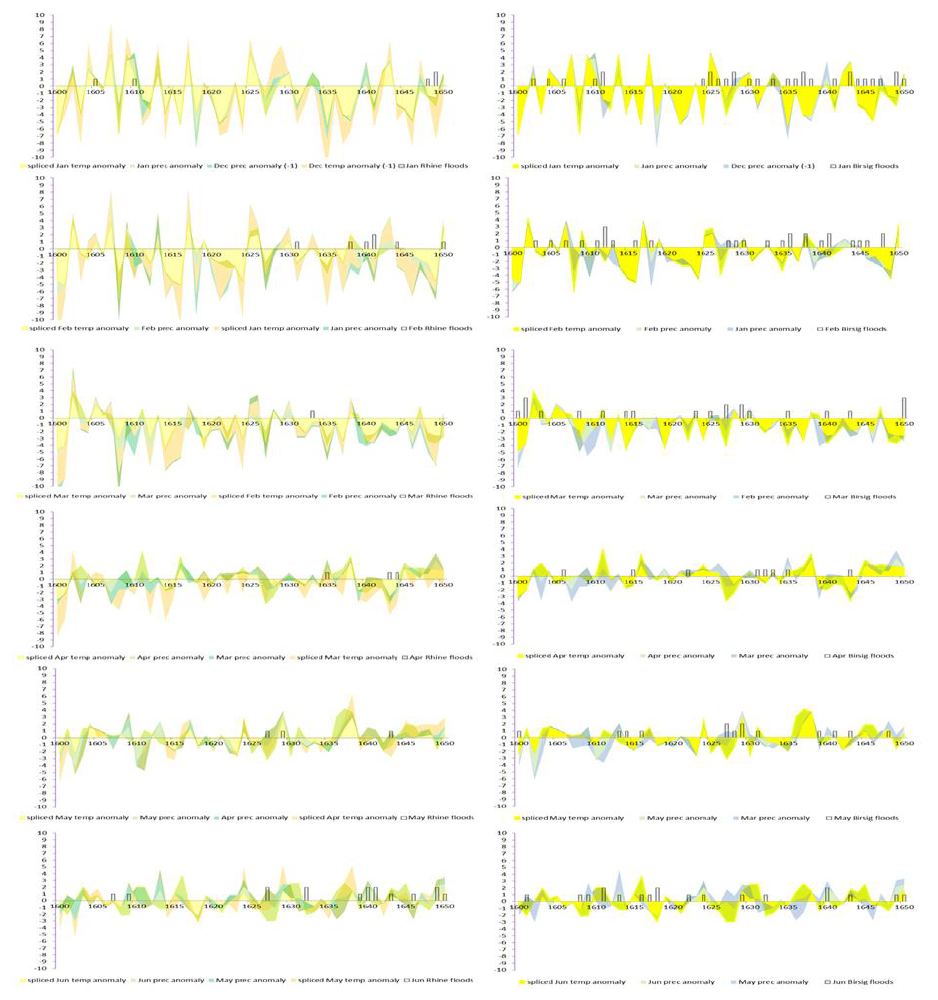
Figure 19. Monthly spliced temperature (Dobrovolný et al., 2009) and precipitation (Pfister, 1999) reconstructions combined with Rhine and Birsig River flood proxies from the weekly books of expenditures from the city of Basel – January to